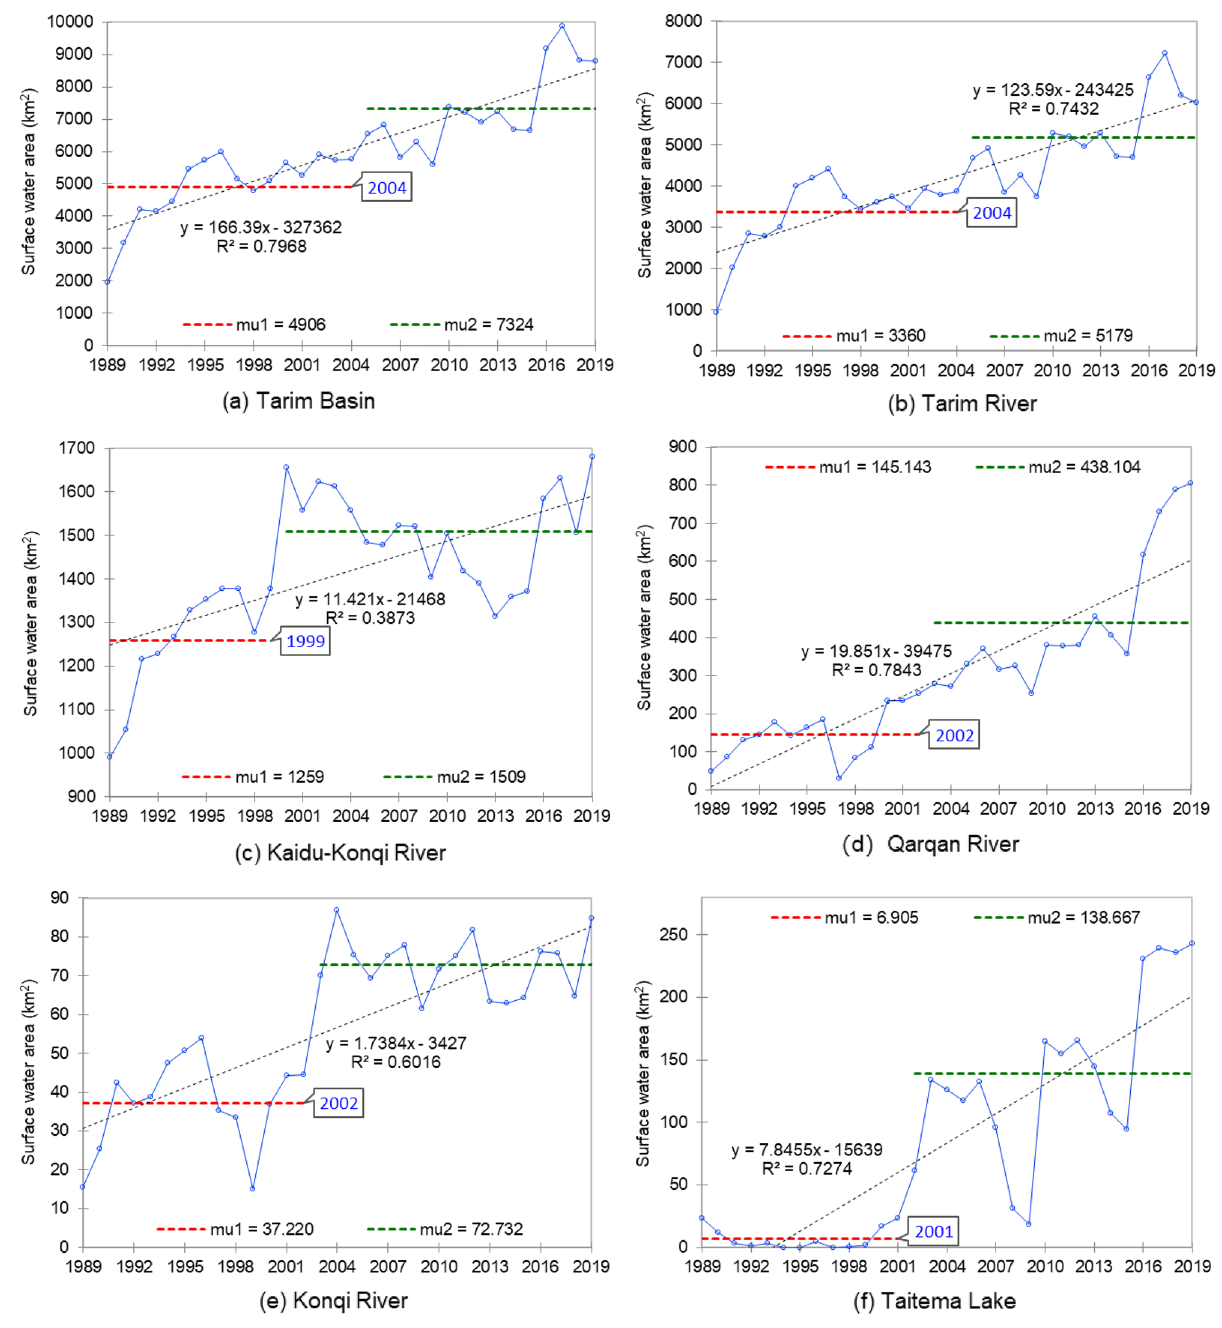
Figure 2. Variation trend and tipping point change of surface water area in the Tarim River Basin and its tributaries from 1989 to